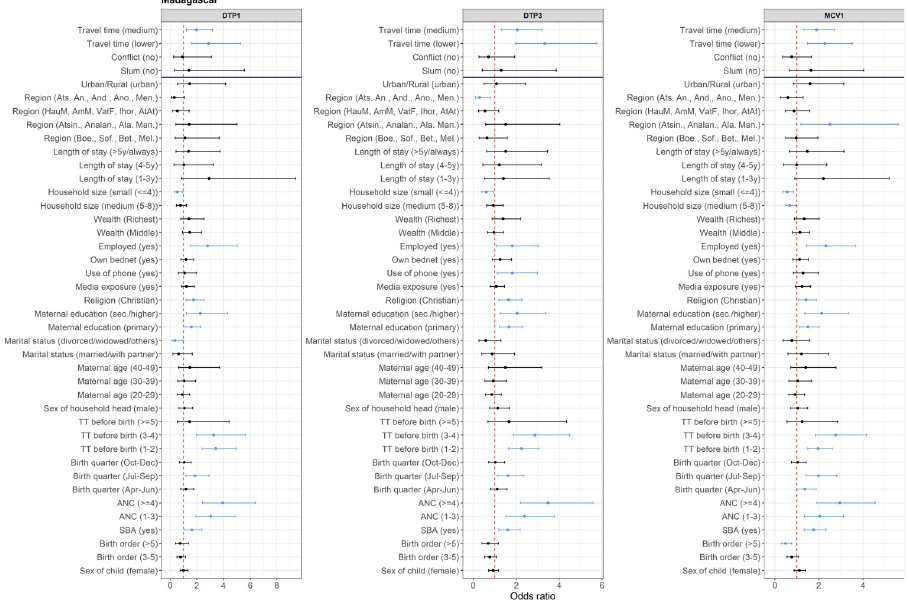
Fig 3. Adjusted odds ratio (aOR) and corresponding 95% credible interval (95% CI) plots for Madagascar. The vertical dotted red lines mark the odds ratio of 1. Light blue dots and lines show the aORs and 95CIs of variables that have significant associations with vaccination. A dark blue horizontal line separates the key community variables from other covariates. See S1 Text for the reference categories of the variables.